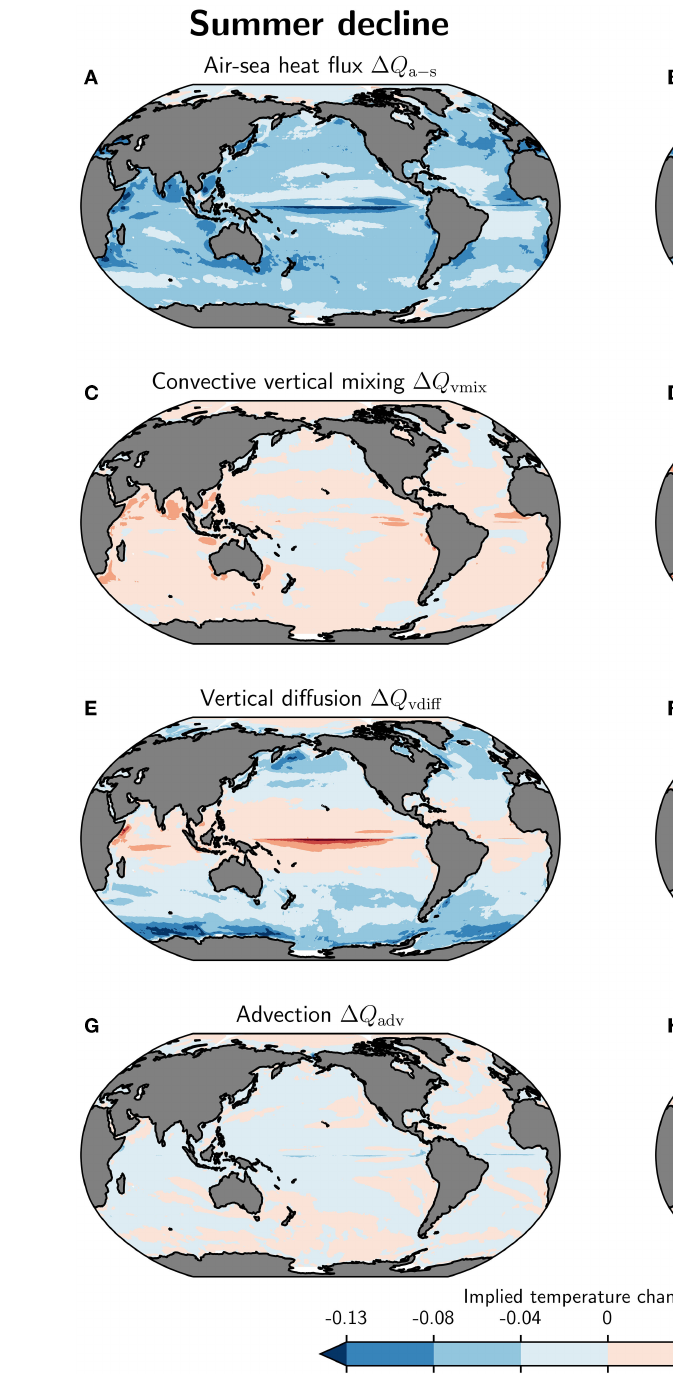
Frontiers in Climate |